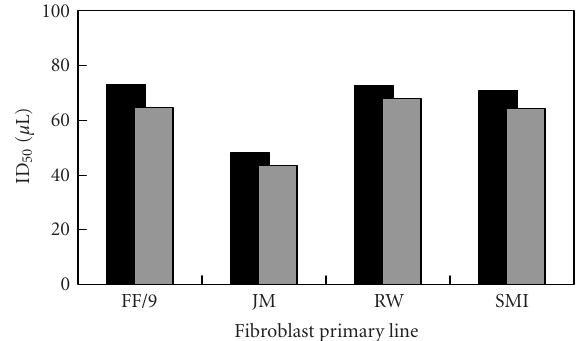
Figure 9. E ff ect of an extract D preparation on 4 di ff erent hu- man fibroblast primary cultures, three from adult patients (JM, RW, and SMI) and one culture of fetal fibroblasts (FF). The bars plot the ID 50 in terms of the volume in microlitres of extract added, each having been prepared to the same mg per mL prior to the start of an incubation for 3 days before estimation. The dark bars show extract from the rapid extraction procedure, and the grey bars show extract from the old procedure. The vari- ation in sensitivity of cell lines around mean ID 50 of approx- imately 60 µ L is relatively small, although JM fibroblasts were clearly more sensitive to both preparations.